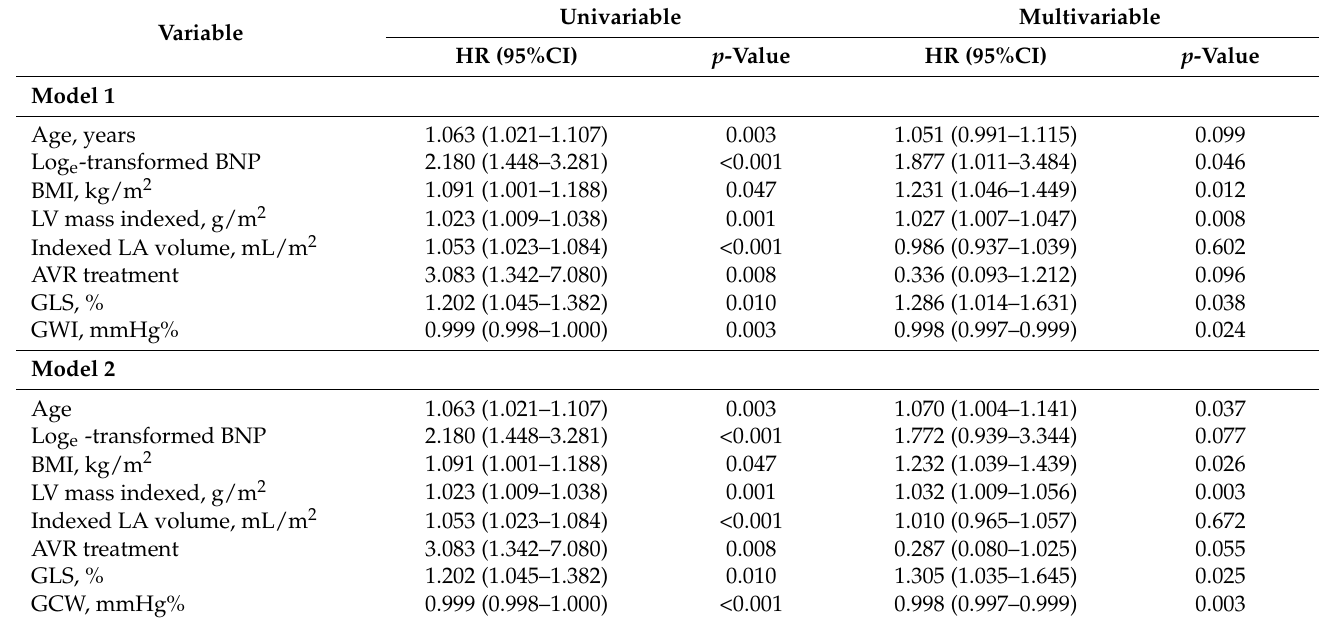
Table 4. Univariable and multivariable Cox proportional hazard model for all-cause mortality for asymptomatic aortic stenosis patients.